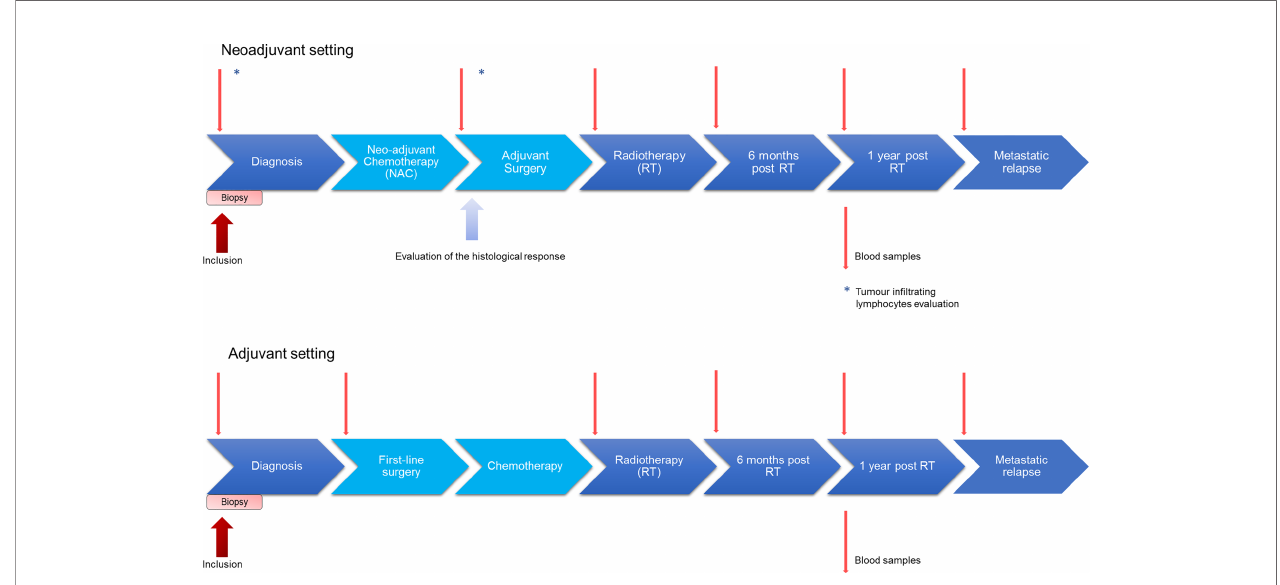
FIGURE 1 | Design of the INSTIGO study. Patients will have blood samples taken at diagnosis, on the day of fi rst-line surgery or post-NAC surgery, on the day of the start of radiotherapy, and 6 months and one year after radiotherapy. If necessary, a blood sample will be taken at the time of diagnosis of metastatic relapse. Blood samples will be used for circulating proteins quanti fi cation, blood cells assay and circulating tumour DNA quanti fi cation. In neoadjuvant setting, TILs rate will be evaluated from tumour tissue from the biopsy and from the operating room.